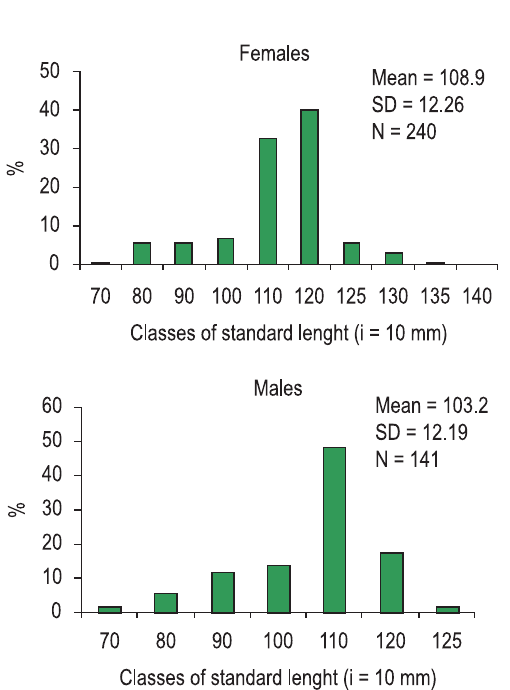
Figure 4. Size distribution for both sexes of A . fasciatus in the Garupa Stream.